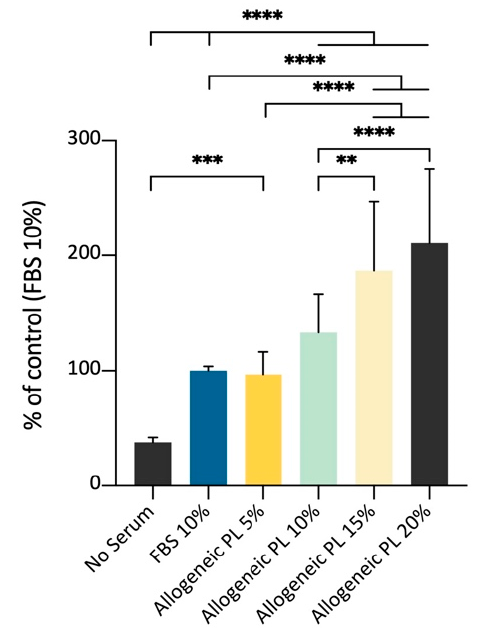
Figure 9. Effects of different percentages of allogeneic PL medium supplementation for the culture of ADMSCs on plastic surface, MTT assay (5000 cells/well; 72 h). Allogeneic PL represents an effective stimulus for cell growth, substituting 10% FBS medium supplementation. Statistically significant differences are indicated as follows: ** p ≤ 0.01, *** p ≤ 0.001, **** p ≤ 0.0001 ( n = 3).